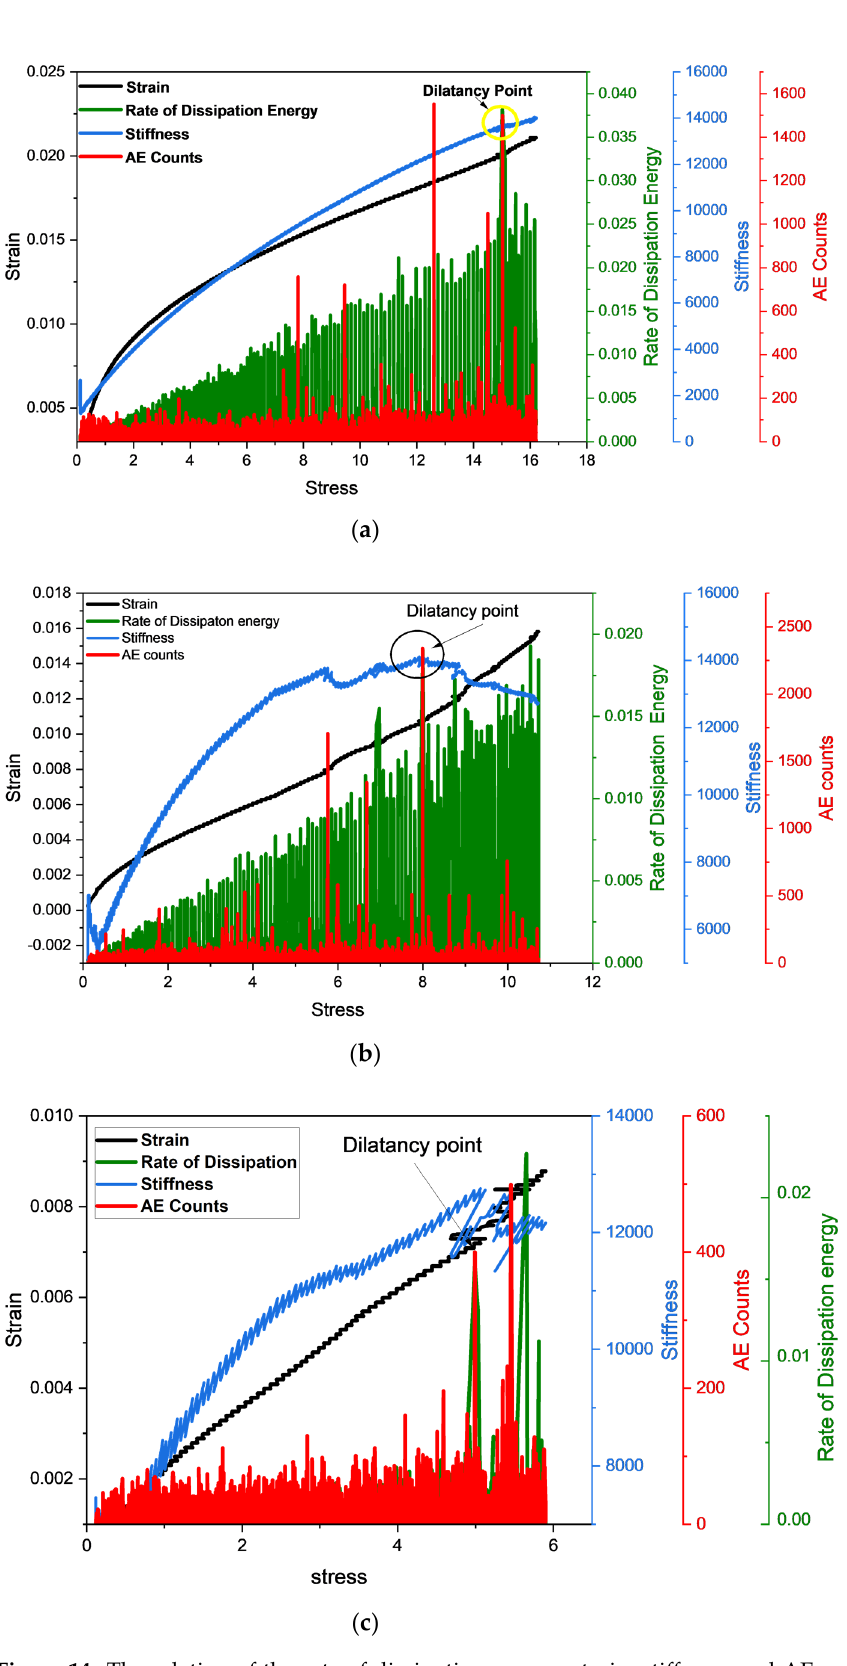
Figure 14. The relation of the rate of dissipation energy, strain, stiffness, and AE counts over the stress of ( a ) dry sample, ( b ) natural sample, ( c ) saturated sample.